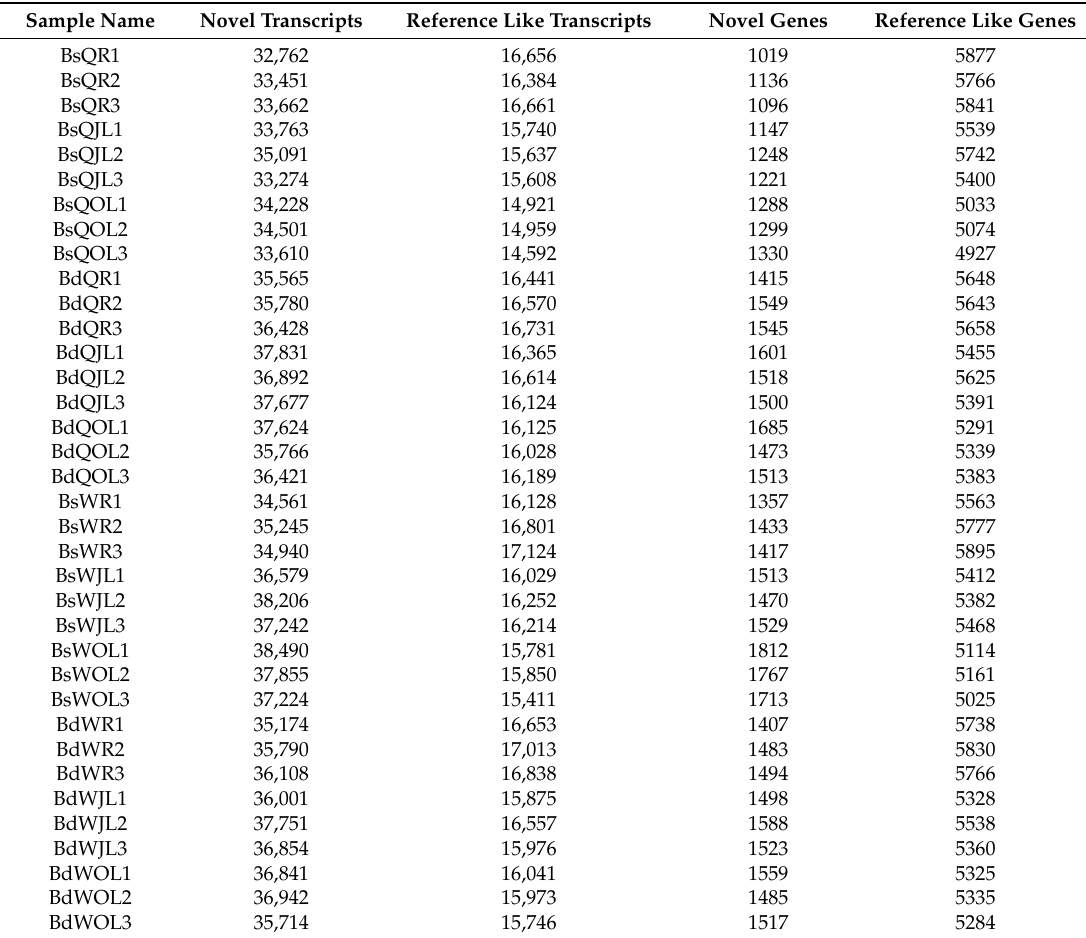
Table 2. The number of novel transcripts and novel genes in the root, juvenile leaves and old leaves of Qingyou10 and Westar10 under B sufficient and deficient conditions (above 1.0